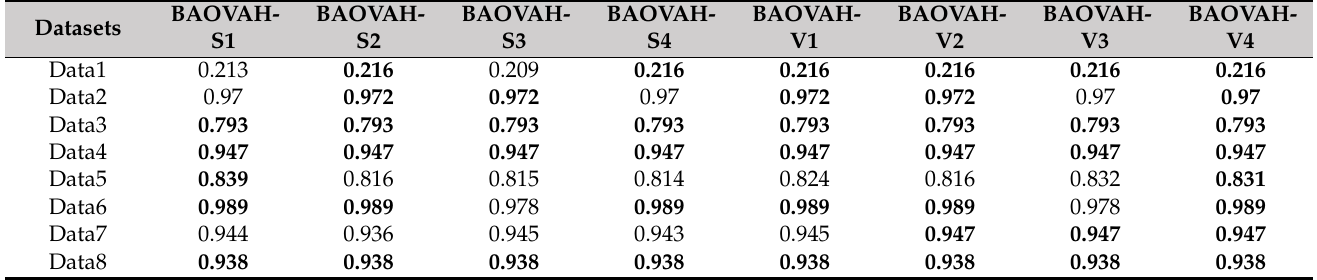
Table 4. Comparison of proposed BAOVA methods based on S-shaped and V-shaped based on average